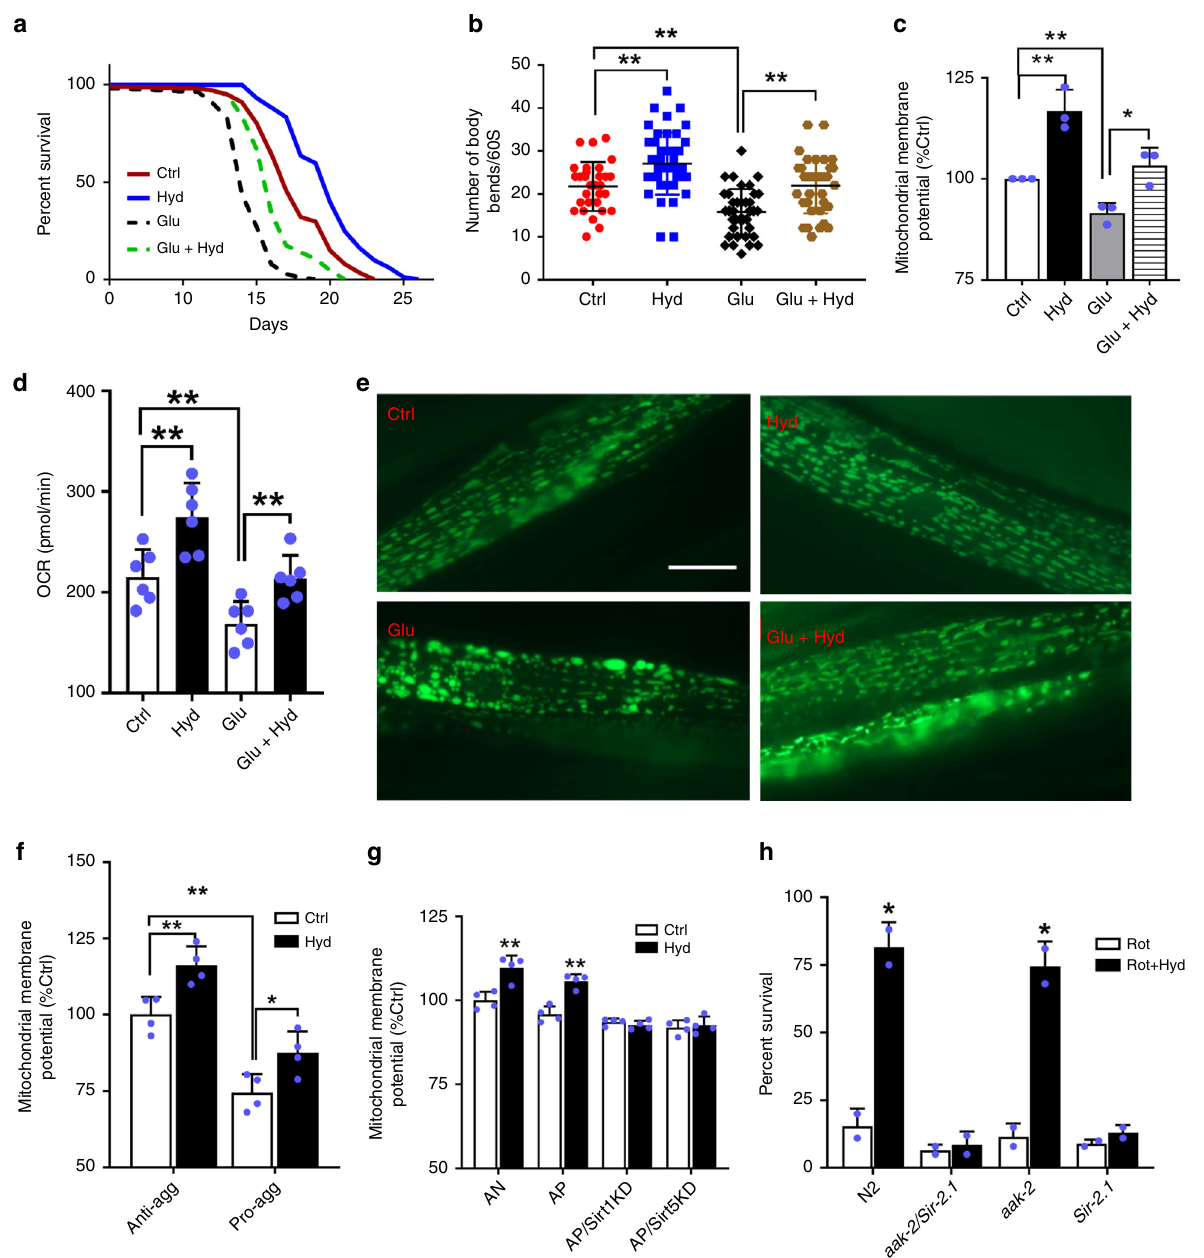
Fig. 4 Hydralazine protects mitochondrial function under different stress conditions. a Hydralazine treatment restores the lifespan of wild-type nematodes grown under high glucose conditions. See Table S1 for lifespan statistics. b Motility assay demonstrates that reduced locomotor performance in 10 days old C. elegans grown under high glucose condition is restored with hydralazine treatment (from left to right N = 30, 43, 40, 36). c Measurement of ΔΨ m shows that hydralazine treatment protects mitochondrial function in C. elegans grown under high glucose diet ( n = 3). d Seahorse XF assay reveals compromised respiration induced by a high glucose diet. Compromised respiration is rescued in the presence of hydralazine in 10 days old nematodes ( n = 6). e Fluorescence microscopy photomicrographs of C. elegans expressing mtGFP reveals protection of mitochondrial morphology under hydralazine treatment in the nematodes grown under high glucose condition for 8 days. Scale bar = 20 µ M. f Measurement of ΔΨ m shows that hydralazine treatment (100 µ M, 4 days) restores the compromised mitochondrial function in C. elegans model of tauopathy expressing pro-aggregant tau fragment in the nervous system ( byIs161 ) ( n = 4). g Quanti fi cation of TMRE fl uorescence signal in AP cells treated with hydralazine (10 µ M, 3 days) demonstrates a SIRT1 and SIRT5 dependent increase in mitochondrial ΔΨ ( n = 4). h The percentage of wild-type and mutant C. elegans survived under rotenone toxicity shows a sirtuin-dependent (not AMPK) mechanism of action for hydralazine (from left to right N = 85, 75, 78, 130, two independent experiments). * p ≤ 0.05 and ** p ≤ 0.01, two-tailed Student ’ s t survival) in animals treated with hydralazine was abrogated in kin- 1 RNAi fed animals which con fi rmed the critical role of PKA orthologue in hydralazine-mediated protection in C. elegans (Fig. 5h). The prolongevity bene fi t of hydralazine was also abrogated in KIN-1 knockdown animals (Fig. 5i).